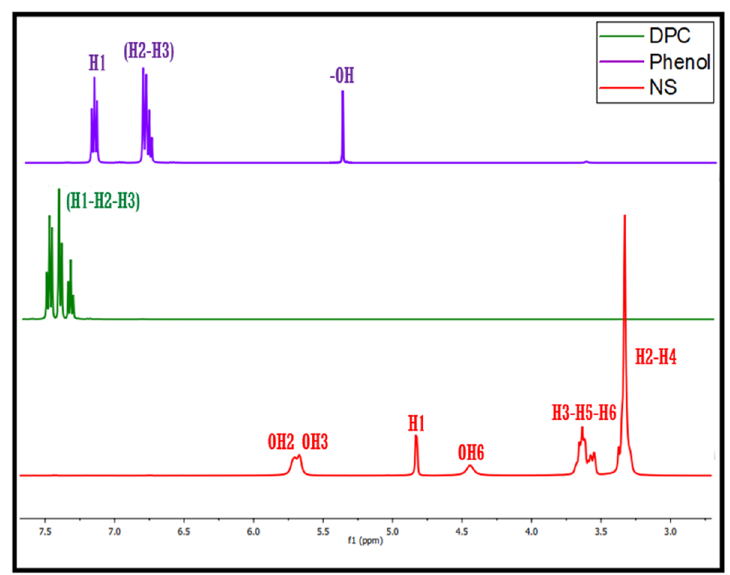
Figure A3. 1 H-NMR (400 MHz, DMSO-d 6 ) of NSs, DPC, and phenol.